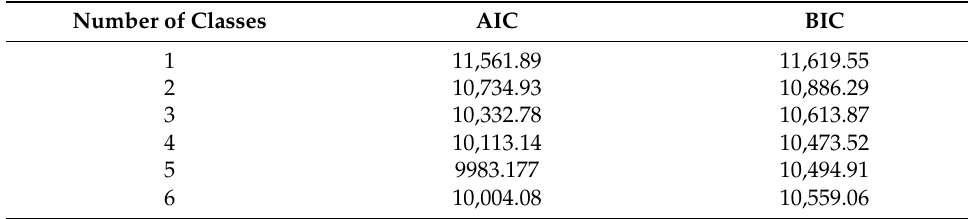
Table 4. Latent class logit model information